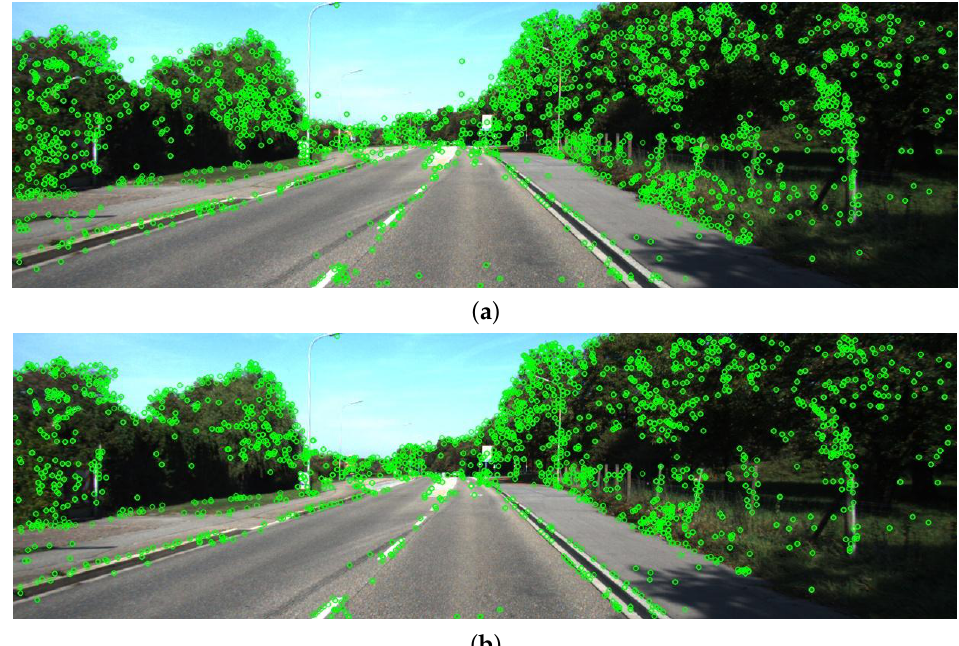
Figure 4. The extraction result of feature points of the 17th reference image. ( a ) Feature point extraction result of the SIFT algorithm; ( b ) feature point extraction result of this